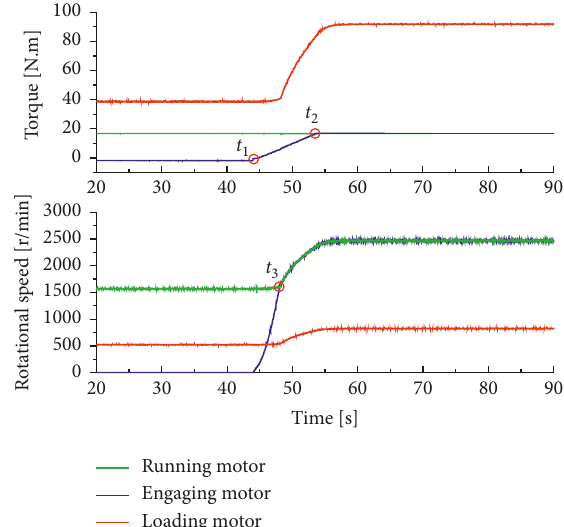
Figure 11: Torque and rotational speed curves during the engaging process.